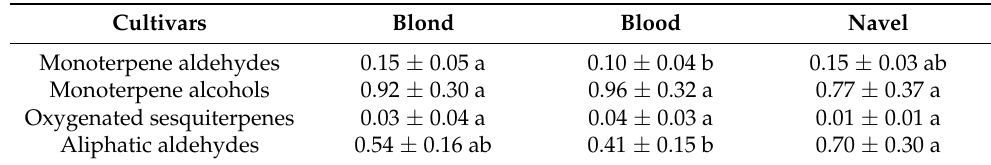
Table 2. Proportion of oxygenated compounds in orange peel oil for the three typical cultivar types. The first number is the mean value, the second is the standard deviation, and the letter is the statistical group according to Tukey’s test ( p ≤